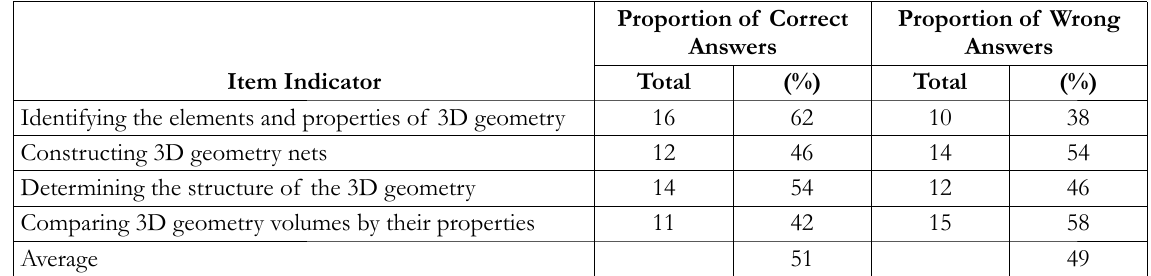
Table 7. The Proportion of Student